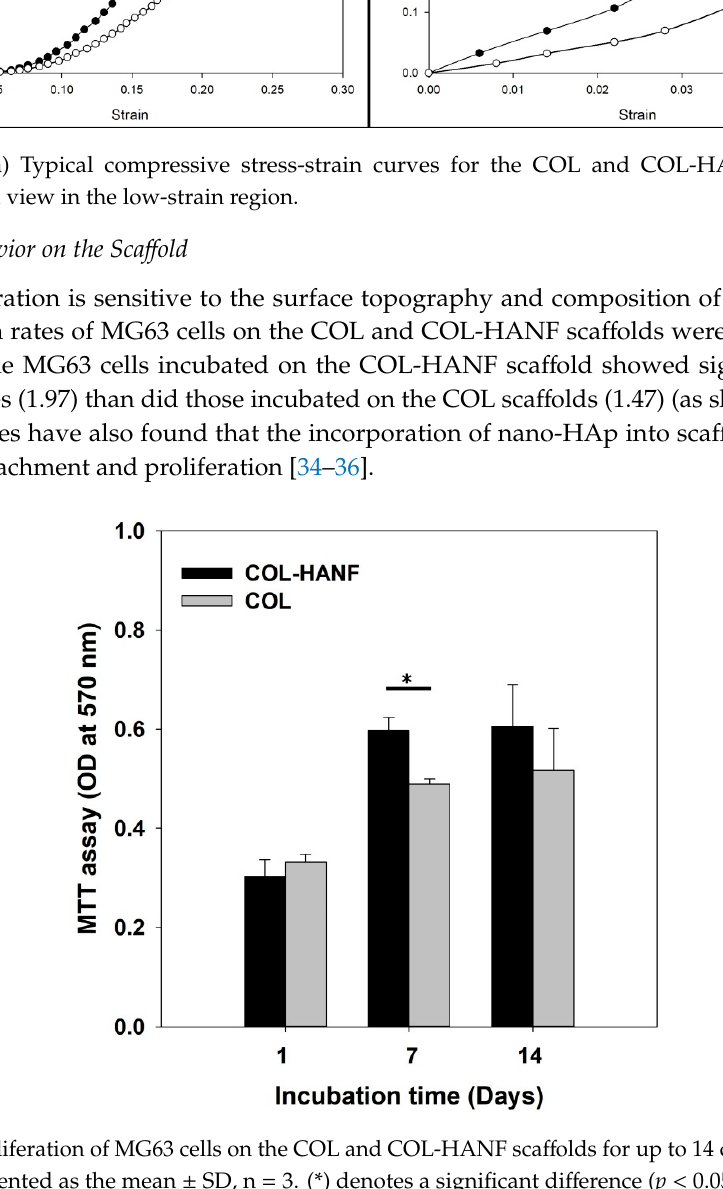
Figure 7. ( a ) Typical compressive stress-strain curves for the COL and COL-HANF scaffolds. ( b ) Expanded view in the low-strain region.